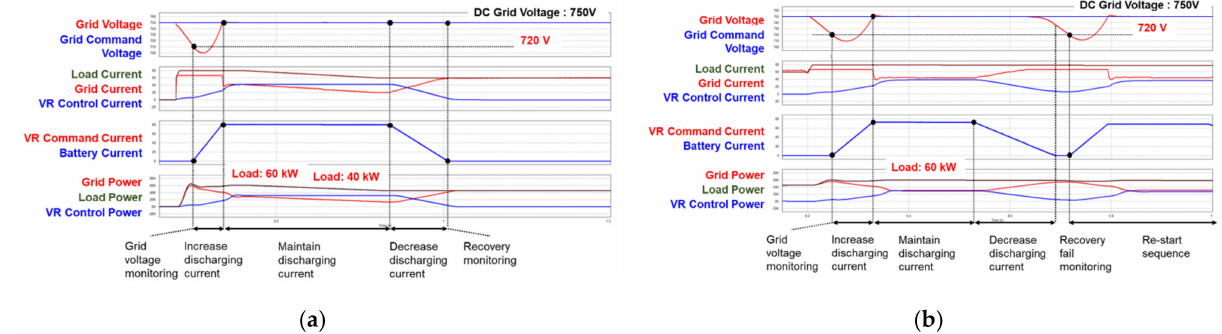
Figure 11. Simulation results of the proposed DC bus voltage regulation method at undervoltage condition: ( a ) when peak load is successfully eliminated; ( b ) when peak load is not eliminated.